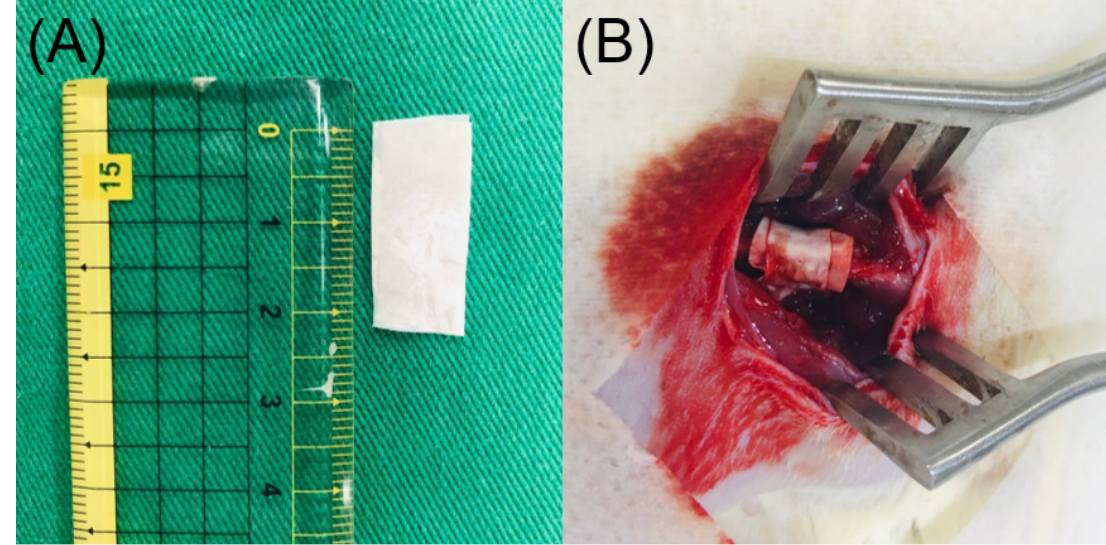
Figure 9. ( A ) A 1 cm × 2 cm membrane was cut from electrospun fluconazole/vancomycin/ceftazidime-loaded poly lactic- co- glycolic acid (PLGA) nanofibers. ( B ) The PLGA membrane was then wrapped on the right femur of the mice.